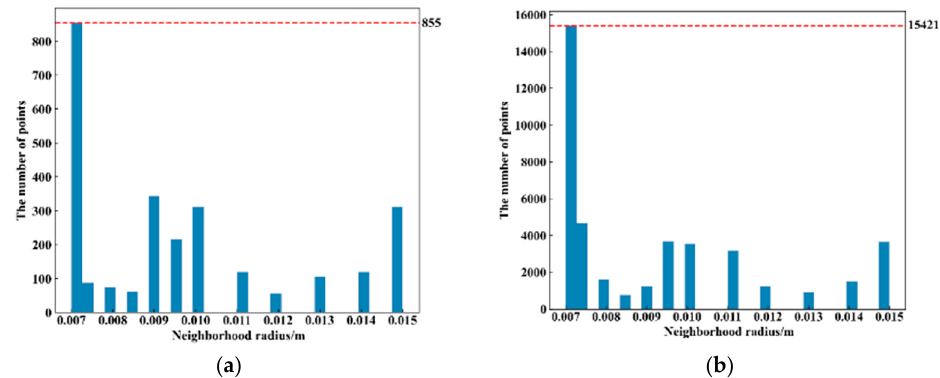
Figure 14. Key points of pallet template point cloud and ground scene point cloud. ( a ) Key points of pallet template point cloud. ( b ) Key points of ground scene point cloud.